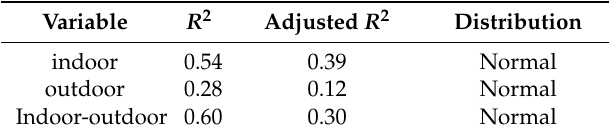
Table 3. OLS R -value results for indoor and outdoor variables.